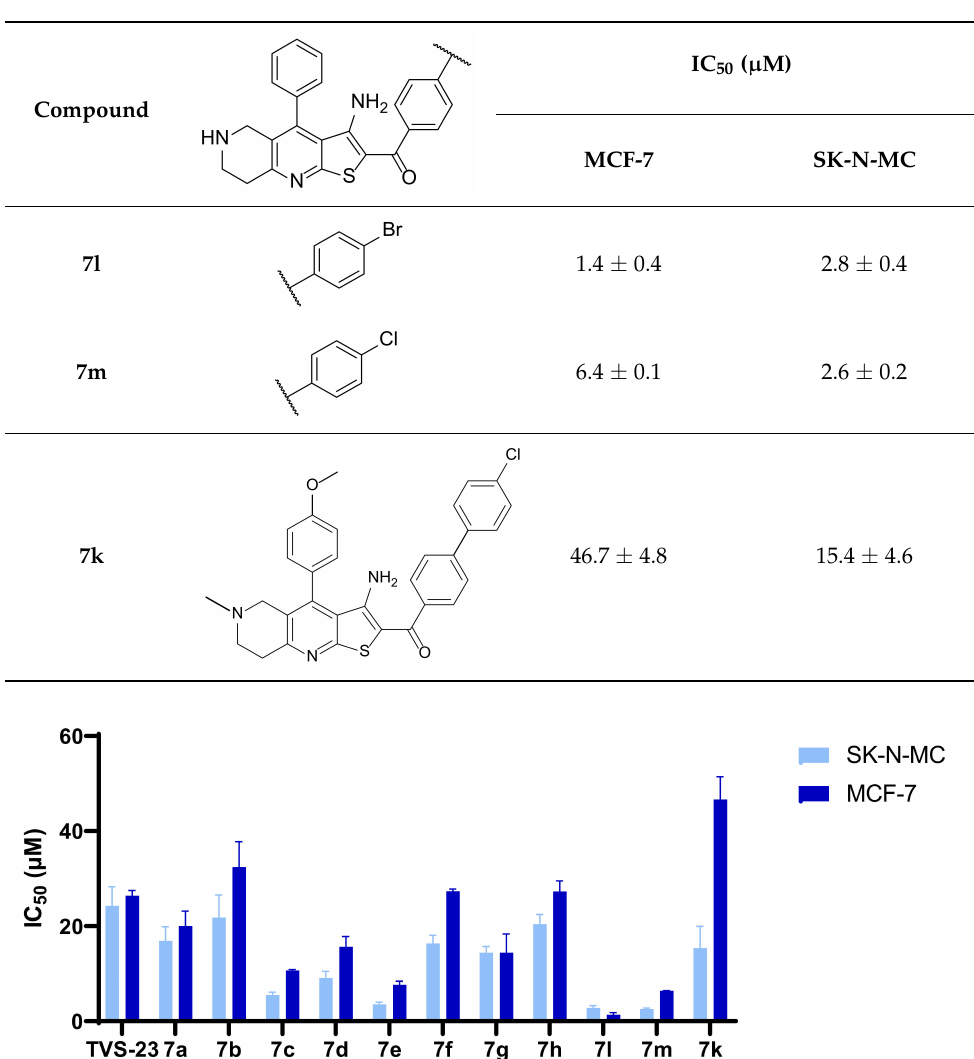
Figure 7. Antiproliferative activity in MCF-7 and SK-N-MC cancer cell lines in MTS assay after treatment with final compounds. Data are means ± SD of two independent